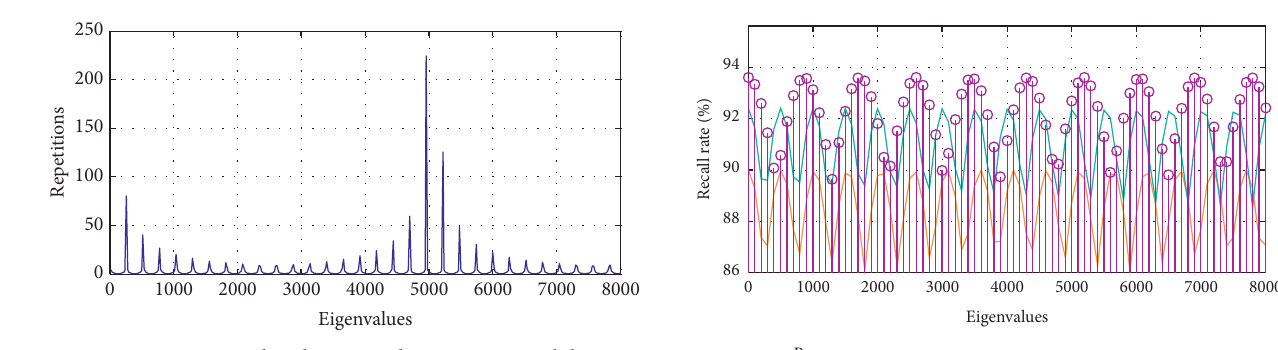
Figure 5: Feature distribution and posture repeatability.